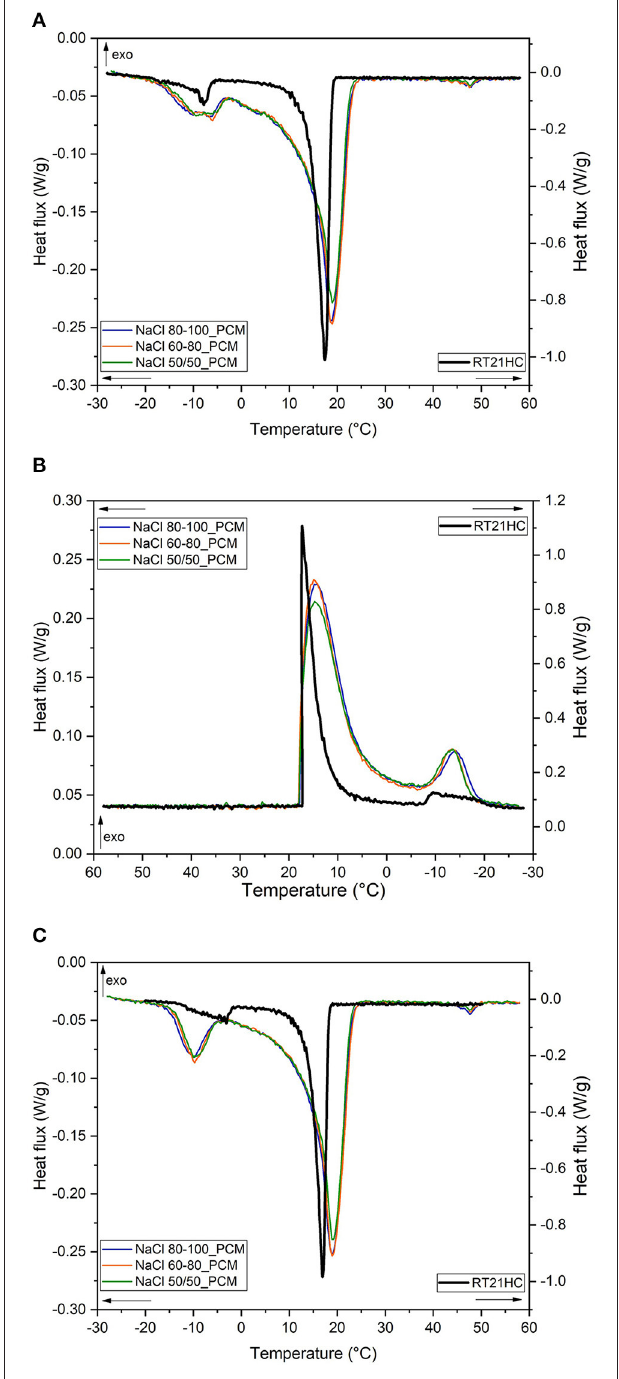
FIGURE 8 | DSC curves of the TES-EPDM foams and PCM at ± 1 ◦ C/min: (A) first heating scan, (B) cooling scan, and (C) second heating scan.